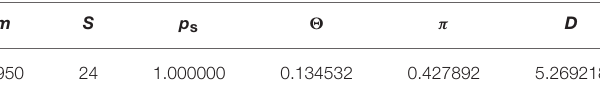
TABLE 5 | Results of Tajima’s Neutrality